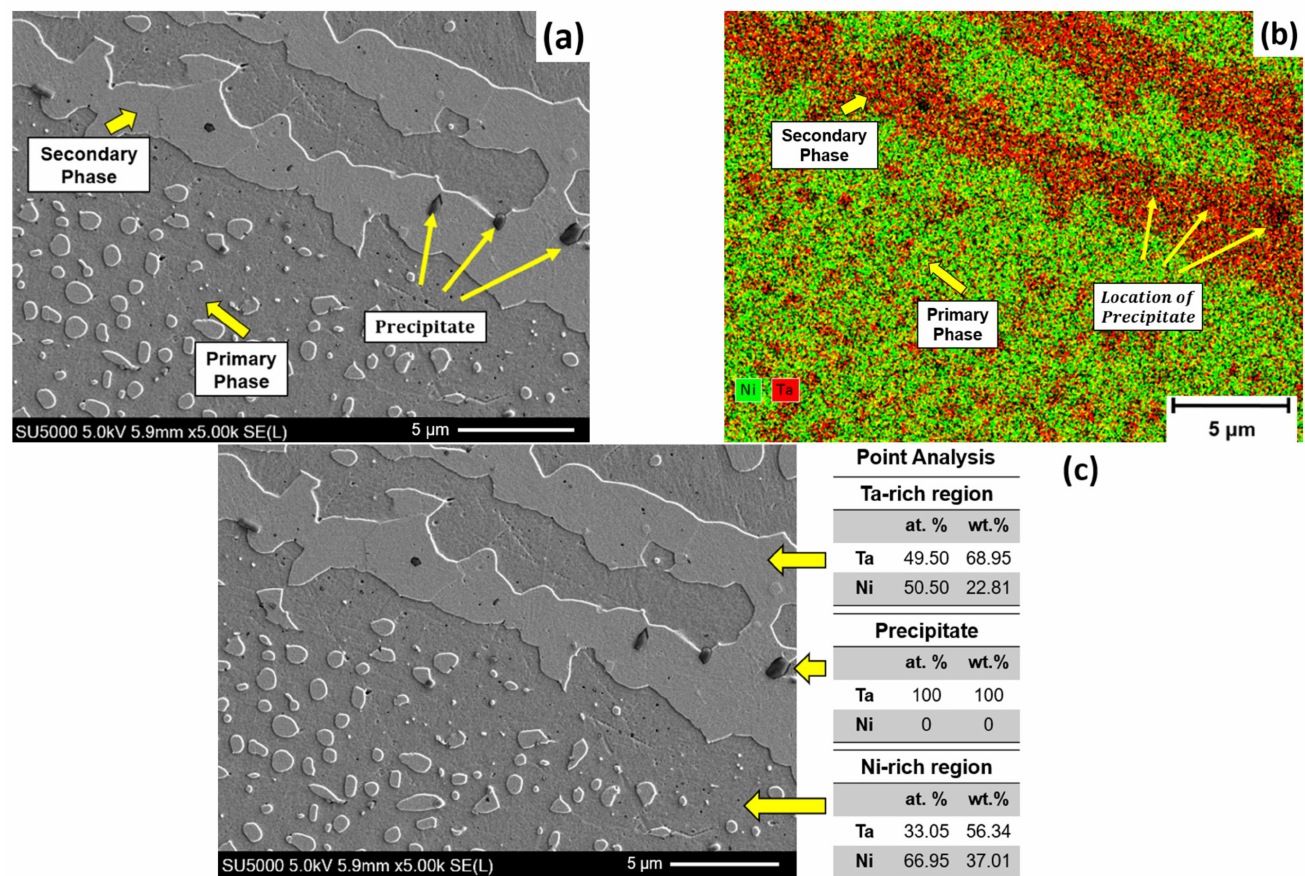
Figure 19. EDX mapping for phase composition and distribution of case 6: ( a ) SEM micrograph, ( b ) EDX map, ( c ) point EDX